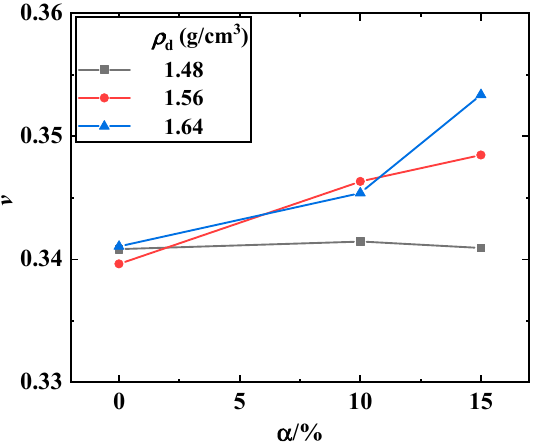
Figure 9. Relationship between Poisson’s ratio and biochar content of the biochar–clay mixture.